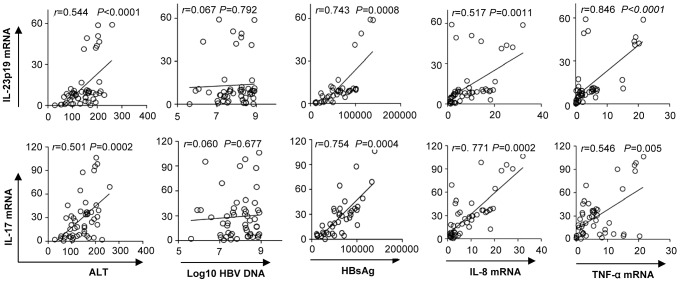

In situ infiltration of IL-23 and IL-17 is significantly correlated with liver injury.Correlations were analyzed between IL-23 or IL-17 and either plasma log10 HBV loads (copies/mL), serum ALT levels (U/L), HBsAg (IU/mL; concentration above 104), IL-8, or TNF-α. Solid line indicates a linear growth trend. r is the correlation coefficient. P-values are shown.